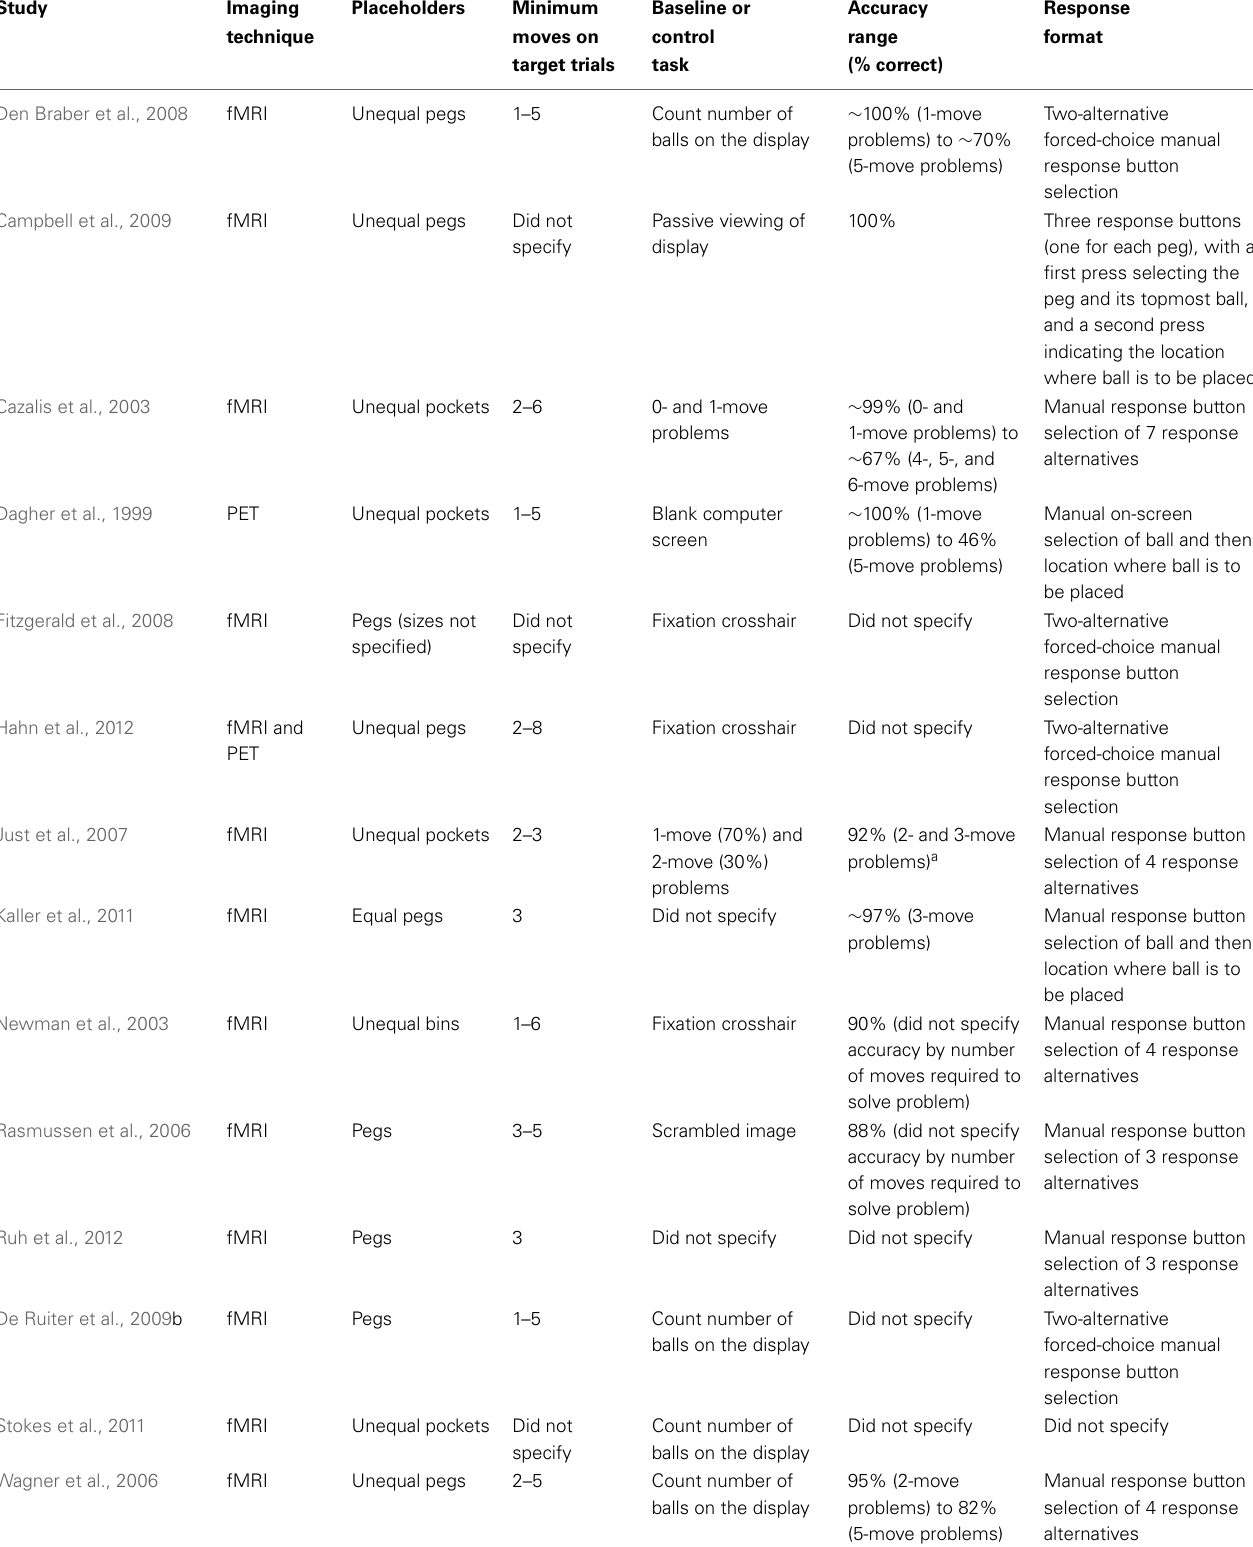
Table 1 | Task parameters for computerized adapted versions of the Tower of London used in functional neuroimaging studies published since